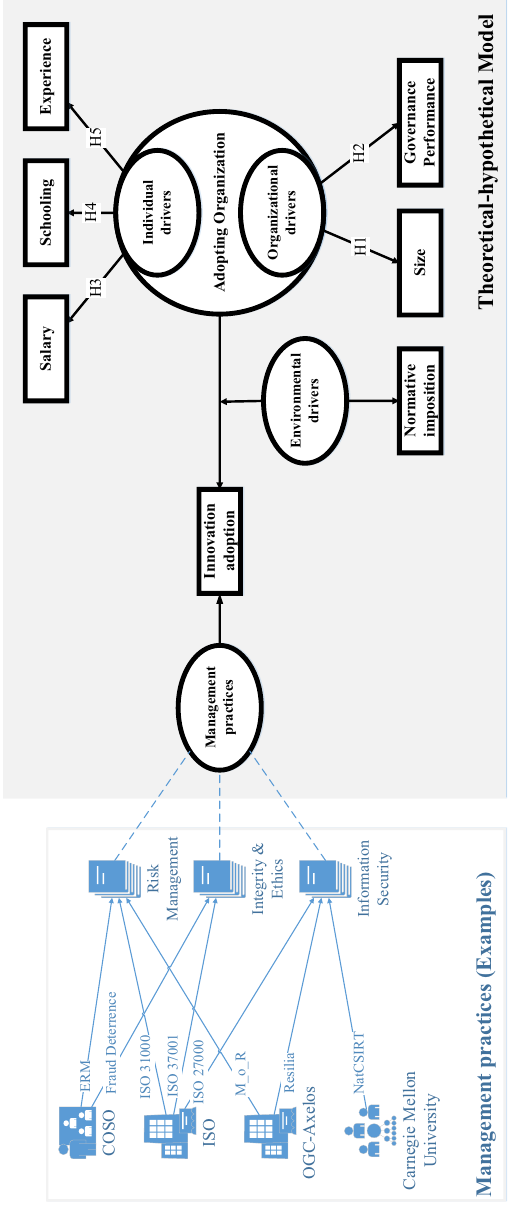
Figure 1. Operational